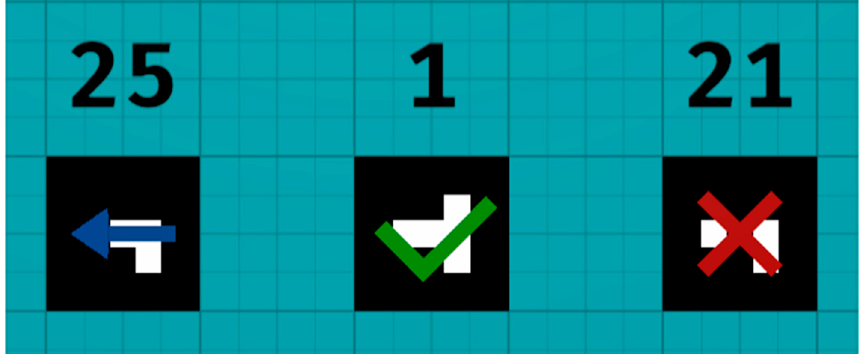
Figure 17. AR visual hints presented in the training simulation with an orthographic rendering.